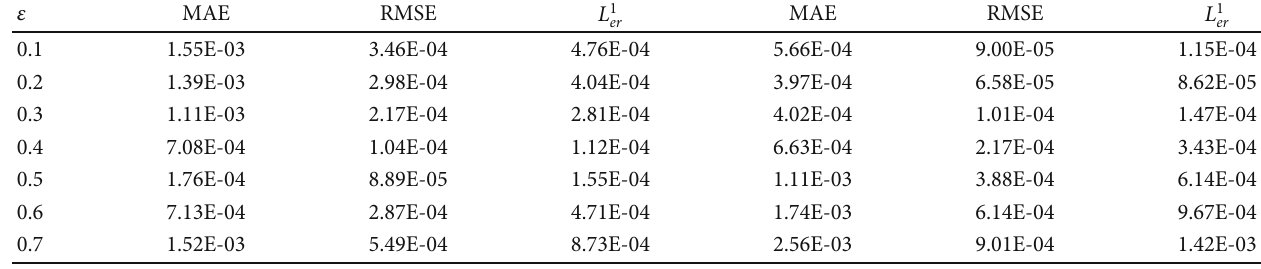
Table 7: Results for di ff erent values of ε in Example 2 with N conditions.